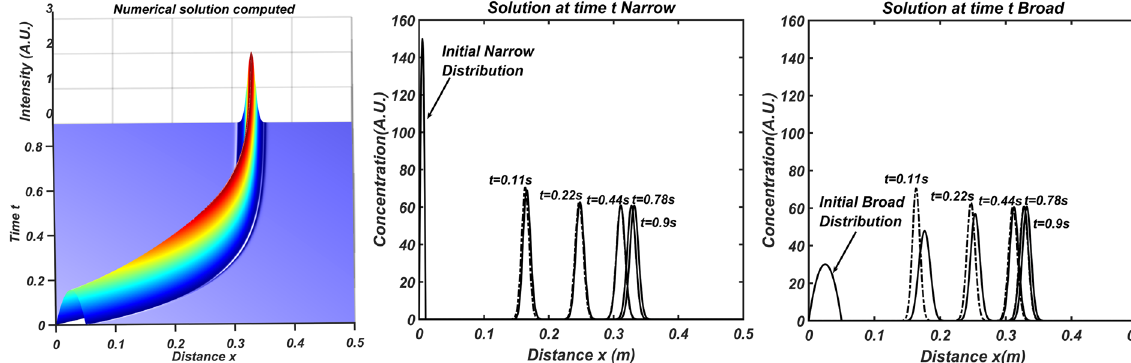
Figure 4. ( A,Left ) 1D numerical solution for eq. (2) showing the position of the distribution as a function of time for an initial broad parabolic distribution n s ( χ ). ( B , C ) Simulation of the 1D IDT eq. (2) at different times. Dashed lines correspond to the analytical solution eq (5-1) while solid lines correspond to the numerical solution at times t = 0s, 0.11s, 0.44s, 0.78s and 0.9s for two cases. ( B,Center ) Initial narrow distribution. ( C,Right ) Initial broad distribution. Diffusion autocorrection is able to narrow down the initial distribution as it travels through the drift